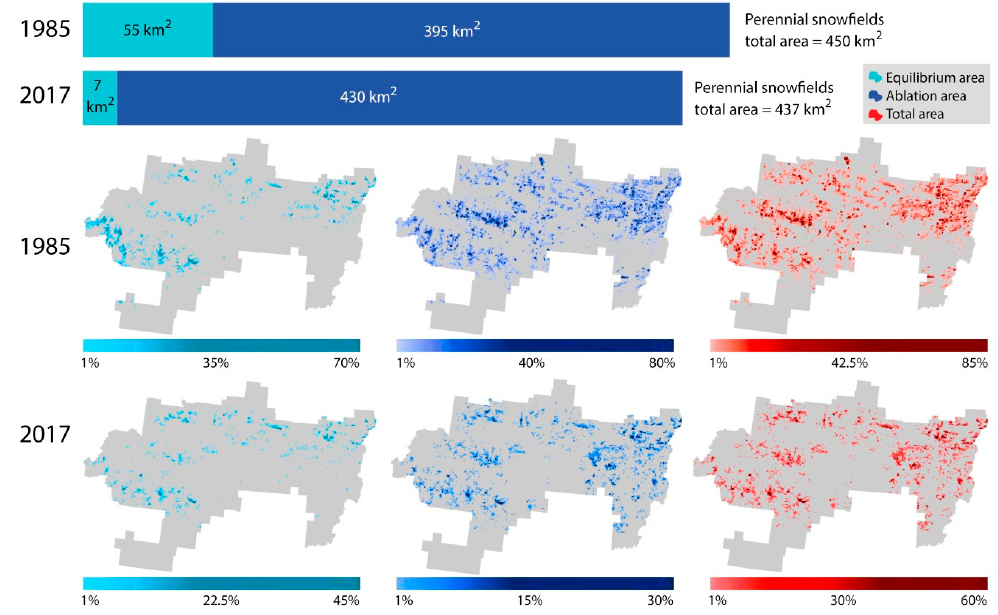
Figure 4. Annual summer season (1 July–15 Aug) perennial snowfield areal extent changes from the beginning of the study time period (1985, derived from the 30 m scale Landsat 4 and 5 imagery) to the end of the study time period (2017, derived from the 15 m scale Landsat 7 and 8 imagery). The top panel shows net changes in the total area between 1985 and 2017, including changes in the sub-classified equilibrium (bright) areas and ablation (dark) areas of the snowfields. The bottom panel shows changes in percent cover between 1985 and 2017 per 1 km 2 grid cell across the entire area of GAAR for equilibrium, ablation, and total areas.